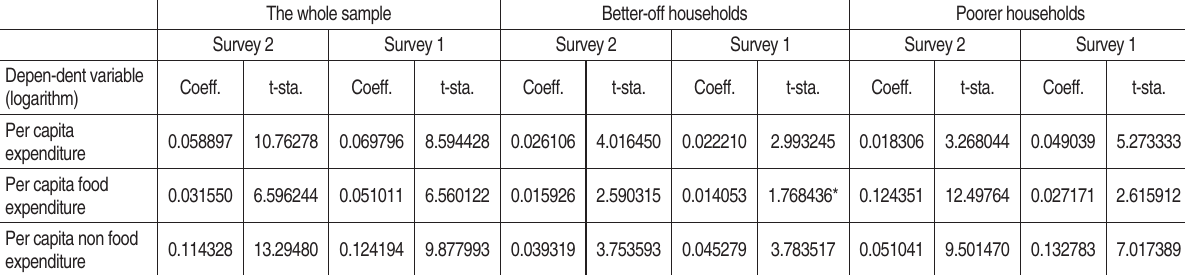
Table 3. Effect of credit on household welfares